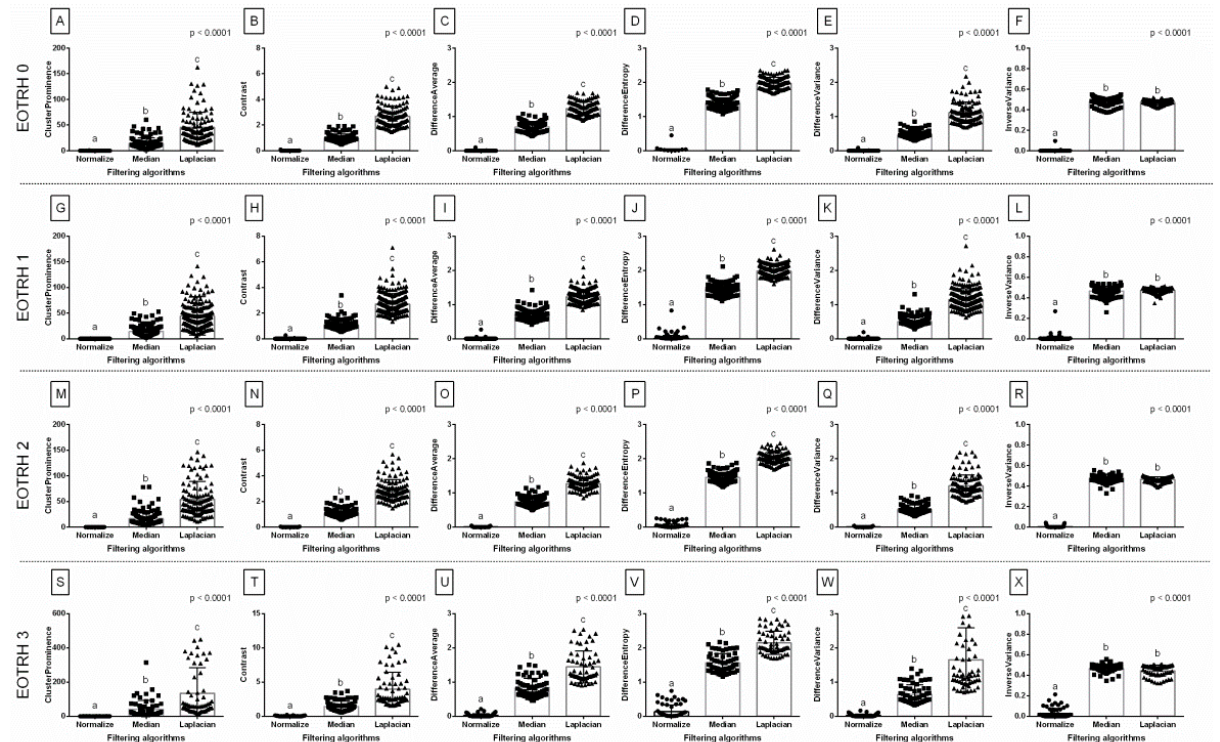
Figure 5. The comparison of the selected Gray–Level Co–occurrence Matrix (GLCM) features between the filtering algorithms. The following GLCM features are considered: Cluster Prominence ( A , G , M , S ), Contrast ( B , H , N , T ), Difference Average ( C , I , O , U ), Difference Entropy ( D , J , P , V ), Dif- ference Variance ( E , K , Q , W ), Inverse Variance ( F , L , R , X ). The radiographs classified to EOTRH 0 grade ( A – F ), EOTRH 1 grade ( G – L ), EOTRH 2 grade ( M – R ), and EOTRH 3 grade ( S – X ) are sepa- rated by dashed horizontal lines. Lower case letters (a–c) indicate differences between groups for p < 0.05 independently for each measure. Single realizations are marked with dots.